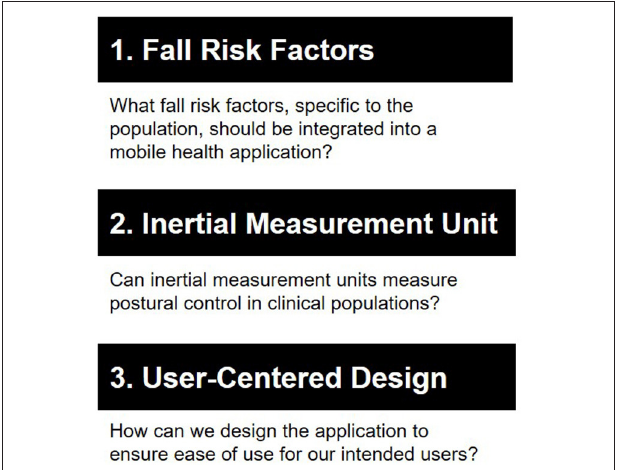
FIGURE 1 | We followed a three-step approach to develop each fall risk application. First, we identified fall risk factors specific to each population that can be measured using mobile technology. Second, we determined whether inertial measurement units within smartphones can measure postural control. Last, we designed the application with a user-centered